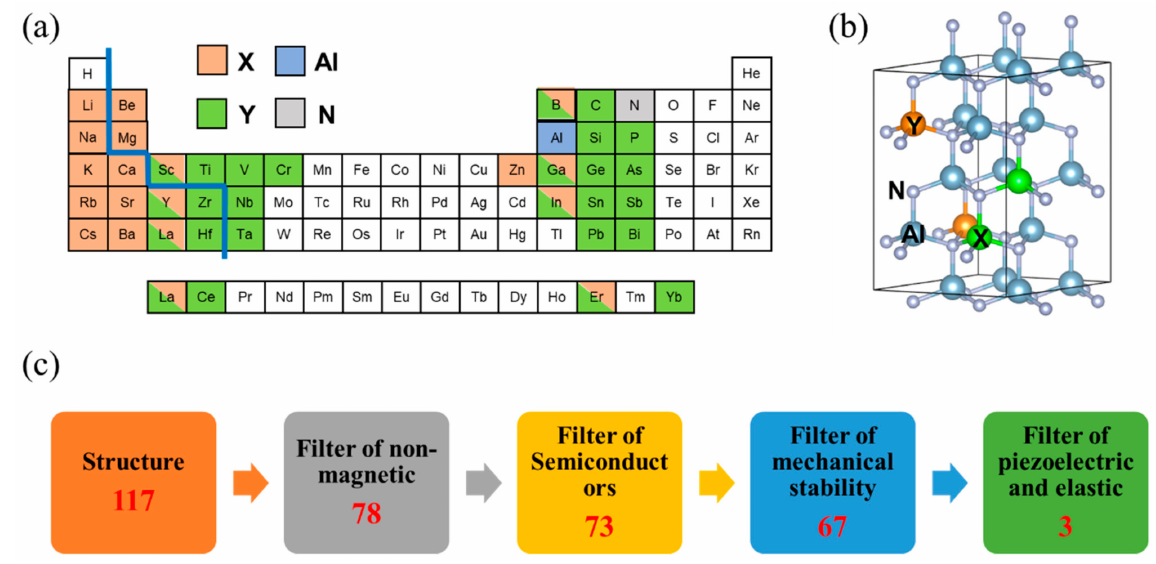
Figure 1. High-throughput workflow of screening piezoelectric material w-X 0.125 Y 0.125 Al 0.75 N. ( a ) Dopants considered in this study. The blue line separates elements X and Y according to an ∆ Ed less than/more than 1.7. ( b ) Crystal structure of w-X 0.125 Y 0.125 Al 0.75 N. ( c ) High-throughput workflow of screening X 0.125 Y 0.125 Al 0.75 N with a high e 33 and high C 33 . The red numbers indicate the number of remaining systems after